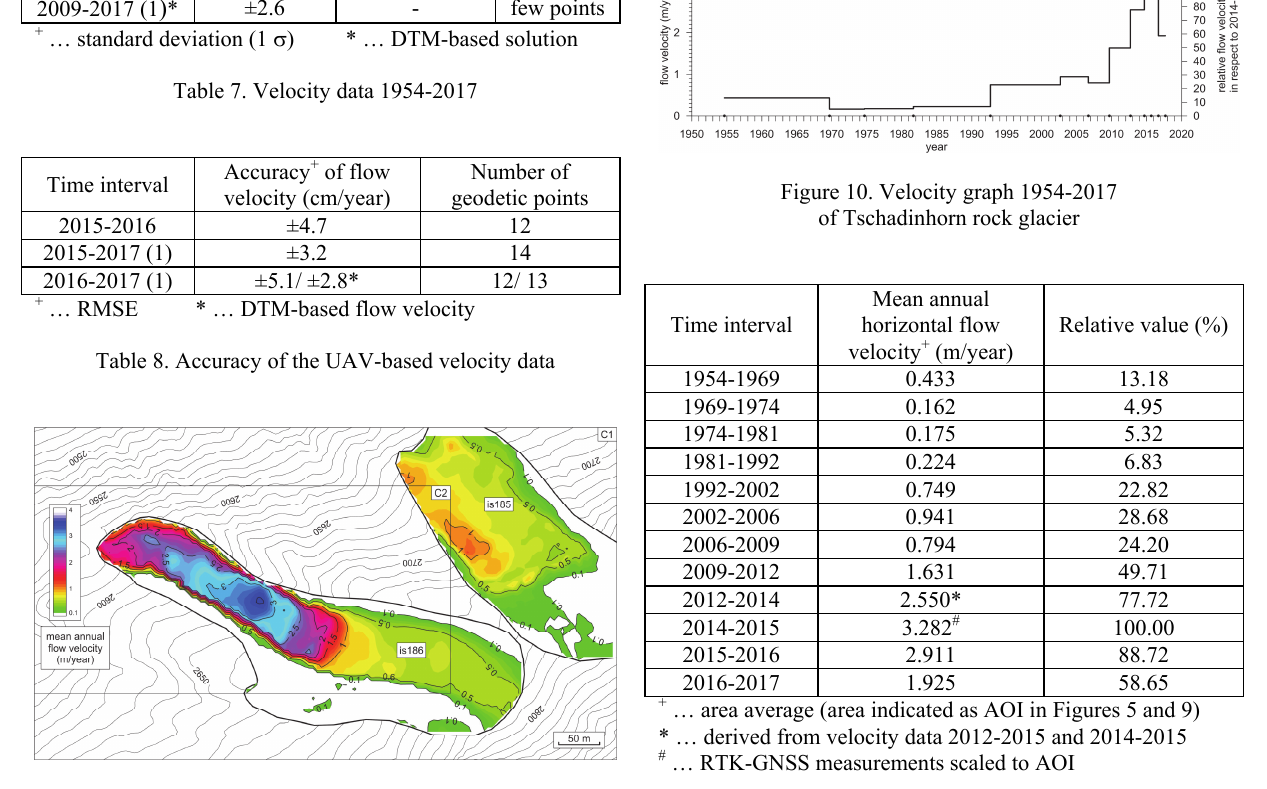
Figure 7. Mean annual horizontal flow velocity 2012-2015